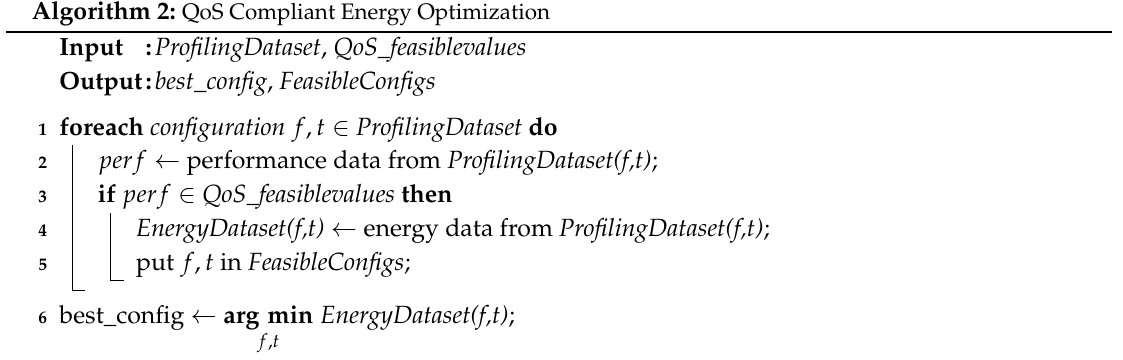
Algorithm 2: QoS Compliant Energy